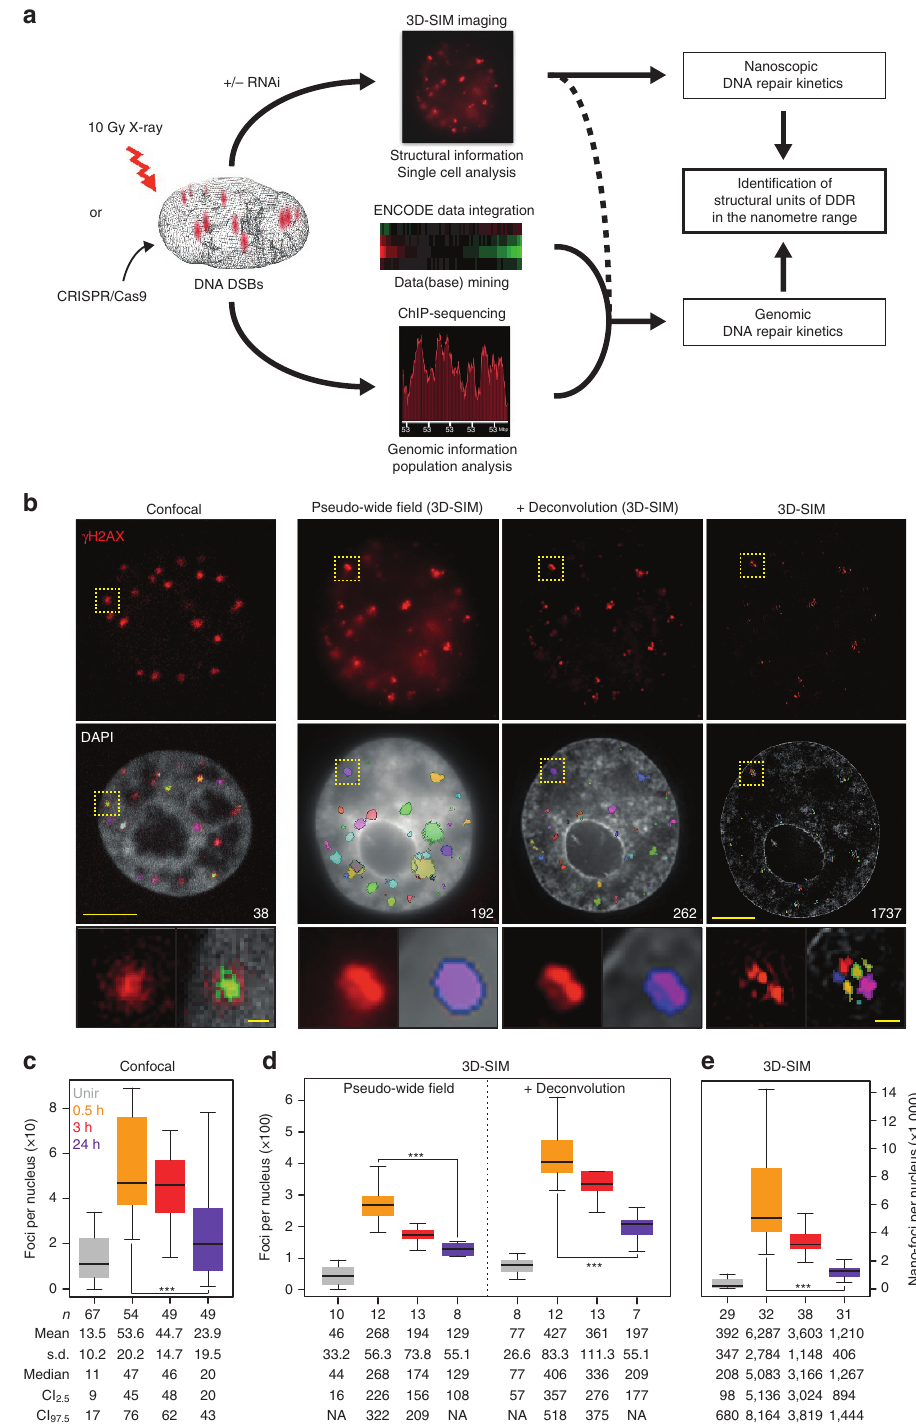
Figure 1 | Characterization of c H2AX foci at different resolution levels. ( a ) Schematics of the experimental approach. ( b ) Mid-nuclear sections of confocal microscopy ( z : 200nm) and 3D-SIM ( z : 125nm) representative images of cells, 24h post IR. Only for 3D-SIM, the same exemplary cell is shown as re-computed pseudo-wide-field image before or after deconvolution as well as the original 3D-SIM output. The total number of detected foci (highlighted in colours) in the whole nuclear volume is shown in the DAPI panels. The lower panels show magnified views of the yellow dashed frame. Scale bars, 5 m m and 500nm for main micrographs and magnified regions, respectively. g H2AX foci number distributions before and during DDR, from confocal images ( c ), 3D-SIM re-computed pseudo-wide-field of identical cell nuclei, before or after deconvolution ( d ) and original 3D-SIM images ( e ). n : total number of imaged cells from three independent experiments. All boxes and whiskers represent 25–75 percentiles and three times the IQD. The mean number of foci and corresponding s.d., the median as well as the 95% confidence intervals (CI) for the median are shown below each box. NA: not applicable. For c – e : one-way ANOVA with Dunnett’s correction; *** P o 10 (cid:2) 3